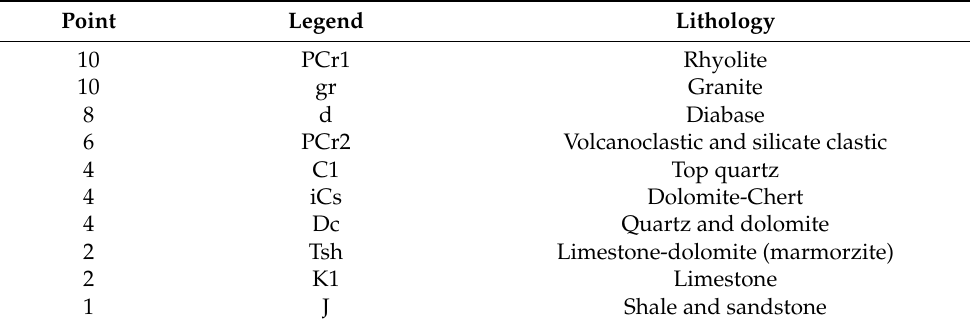
Table 5. Geological layer classification for integration by multi-class index overlap